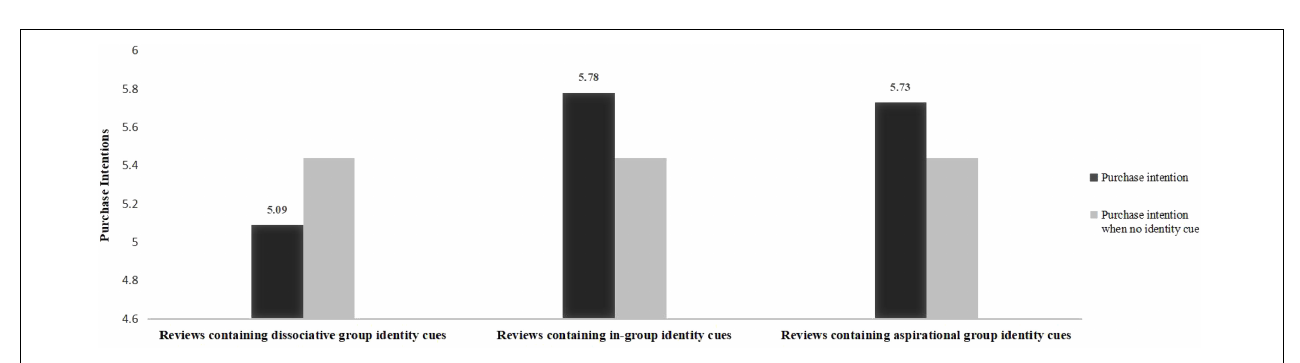
FIGURE 2 | Comparison of purchase intentions after reading product reviews.